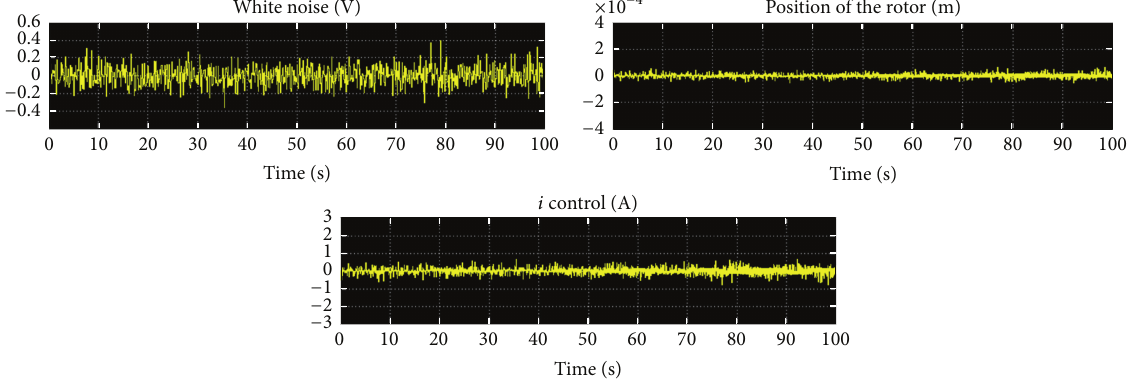
Figure 7: System response with P controller with proportional gain of 12000 and white noise of 0.001 volts.